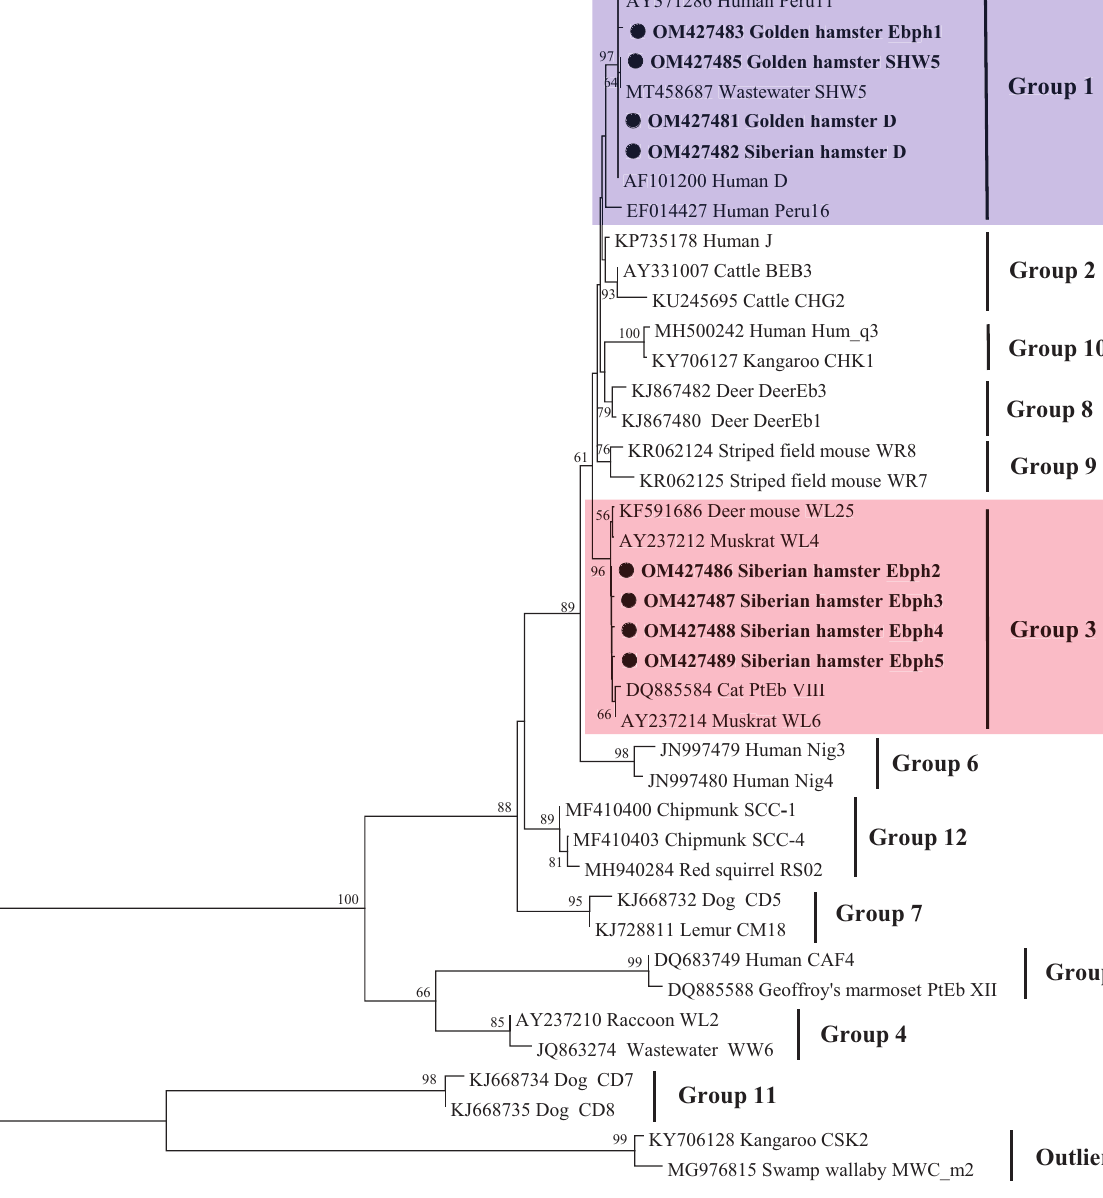
Fig. 2. Phylogenetic relationships among the genotypes of E. bieneusi identi fi ed in this study and other known genotypes, as inferred by a neighbor-joining analysis of the ITS region. Bootstrap values above 50% from 1000 pseudoreplicates are shown. The genotypes identi fi ed in this study are indicated by closed